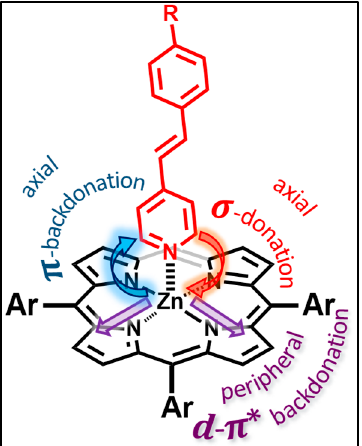
Figure 2. Possible interactions in axially substituted metal porphyrins.